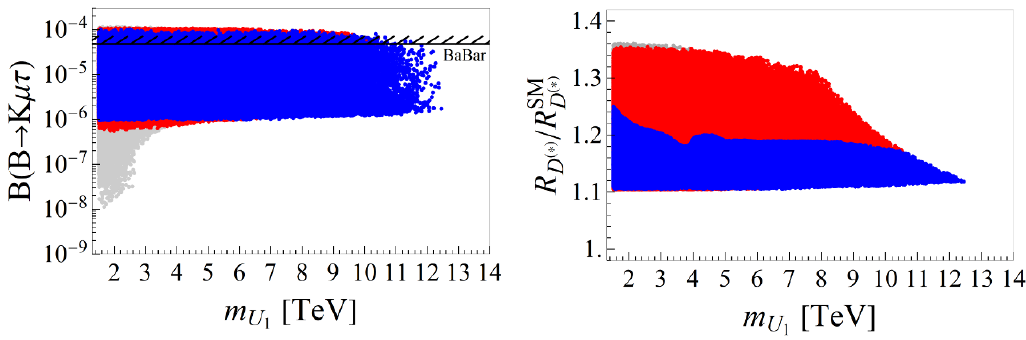
=R SM (right panel) for the D ( (cid:3) ) D ( (cid:3) )